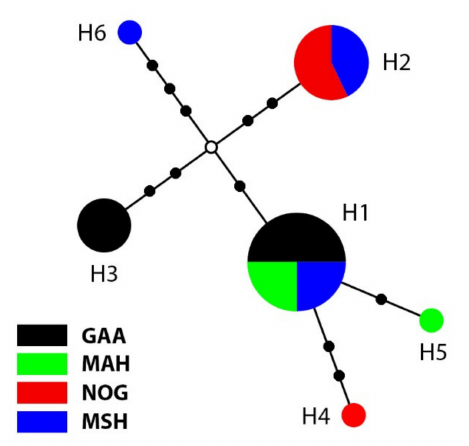
Figure 4. The relationship of COI haplotypes distribution among invasive A. franciscana populations (Abbreviations listed in Table